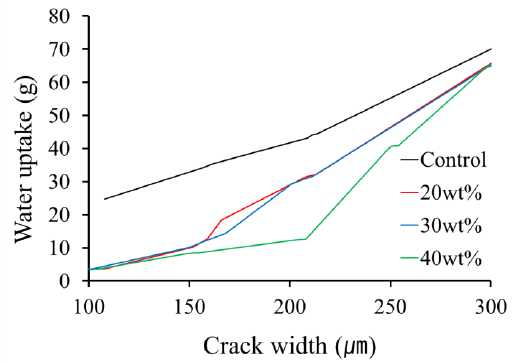
Figure 3. Water uptake versus crack width of the self-healing coatings with capsule-loading of 0 (control), 20 wt%, 30 wt% and 40 wt%. Mean diameter of the microcapsules and undercoating thickness were 65 µm and 50 µm, respectively.